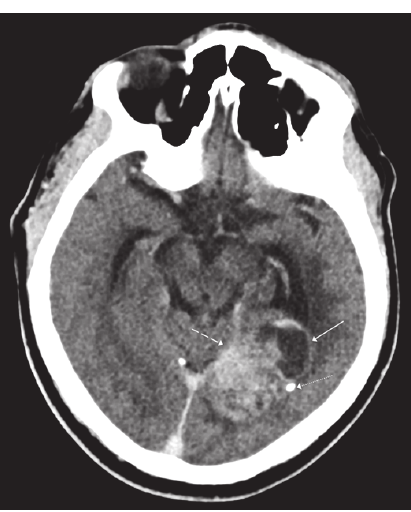
Figure 3: Postcontrast axial T1 weighted MR image demonstrates avid heterogeneous enhancement in the solid component (dashed white arrow) with rim enhancement of the cystic component.